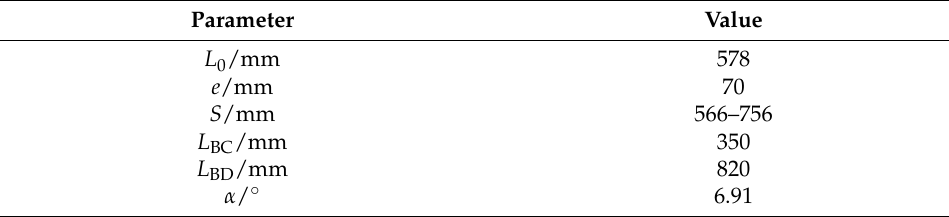
Table 1. Dimension parameters of the front-suspension